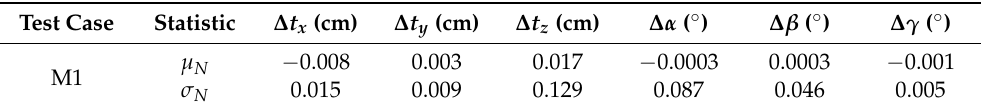
Table 16. Mean and standard deviation of the pose estimation errors in presence of uncertainties in the positioning of the markers on the target for test case